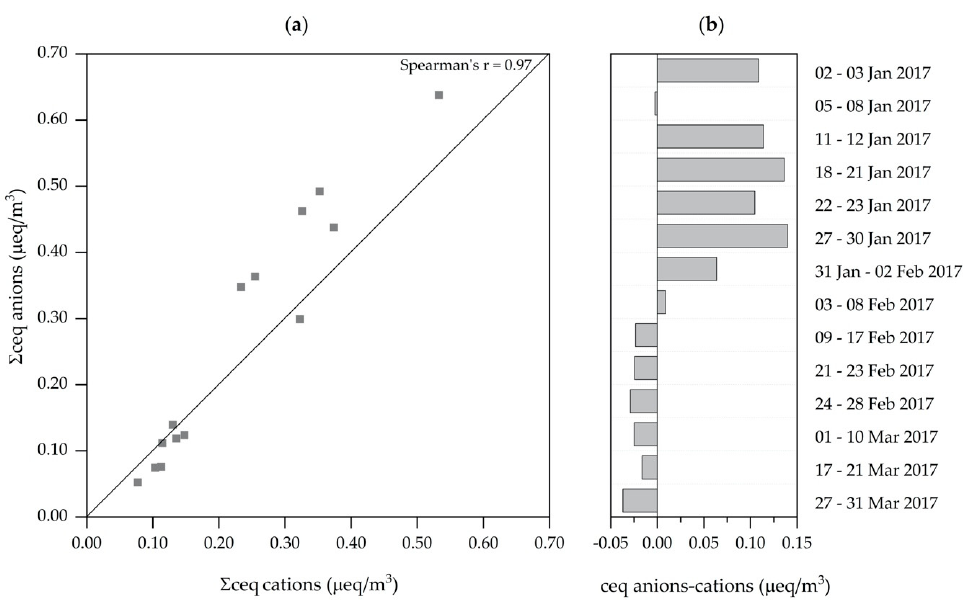
Figure 3. ( a ) Ion balance of pooled PM 2.5 samples at the monitoring station located in Graz Don Bosco (DB), 2 January–31 March 2017. ( b ) Temporal variations of ion balances for individual sampling pools.